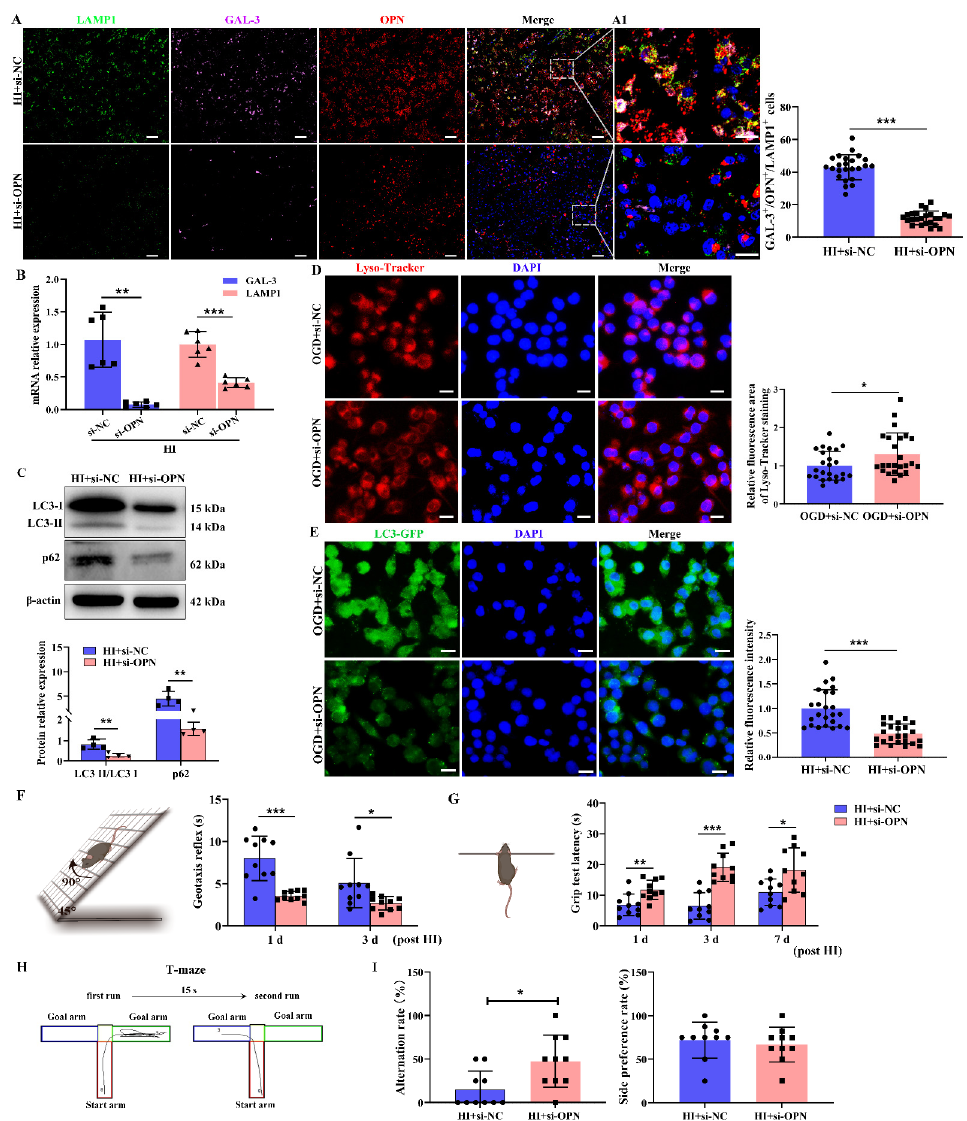
Figure 3. OPN deficiency attenuated lysosome damage and autophagosome accumulation after HI insult. ( A ) Immunofluorescence images of LAMP1, GAL-3, and OPN in the HI+si-OPN or HI+si-NC group ( n = 4). Scale bar = 50 µm; A1: Magnified views of boxed regions in ( A ) showing the colocalization of LAMP1, GAL-3, and OPN. Scale bar = 20 µm. ( B ) GAL-3 and LAMP1 mRNAs in HI+si-NC or HI+si-OPN group were detected by qRT-PCR ( n = 6). ( C ) The protein levels of LC3-II and p62 in the HI+si-NC or HI+si-OPN group were measured with Western blot ( n = 4). All experiments were performed three times. ( D ) BV-2 cells were exposed to OGD after transfection with si-NC and si-OPN, then incubated with Lyso-Tracker Red ( n = 6). Scale bar = 20 µ m. ( E ) Immunofluorescence images of LC3-GFP after OGD in BV-2 cells transfected with si-NC and si-OPN ( n = 4). Scale bar = 20 µ m. ( F ) Geotaxis reflexes tests on 1 d and 3 d after HI exposure in the HI+si-NC and HI+si-OPN groups ( n = 10). ( G ) Grip tests on 1 d, 3 d, and 7 d after HI exposure in the HI+si-NC and HI+si-OPN groups ( n = 10). ( H ) Diagram of T-maze. ( I ) Alternation rate and side preference rate in HI+si-NC and HI+si-OPN groups ( n = 10). Values represent the mean ± SD, * p < 0.05, ** p < 0.01, *** p < 0.001 according to the t -test. d, days; DAPI, 4 (cid:48) ,6 (cid:48) -diamidino-2-phenylindole dihydrochloride hydrate; HI, hypoxia–ischemia; LAMP1, lysosomal-associated membrane protein 1; LC3, microtubule-associated protein 1 light chain 3; NC, negative control; OGD, oxygen–glucose deprivation; OPN,